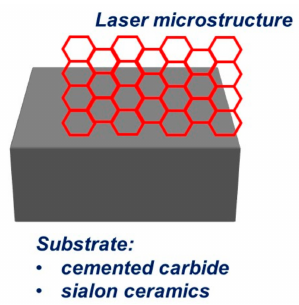
Figure 1. Diagram of laser micro-texturing idea of sintered tool materials